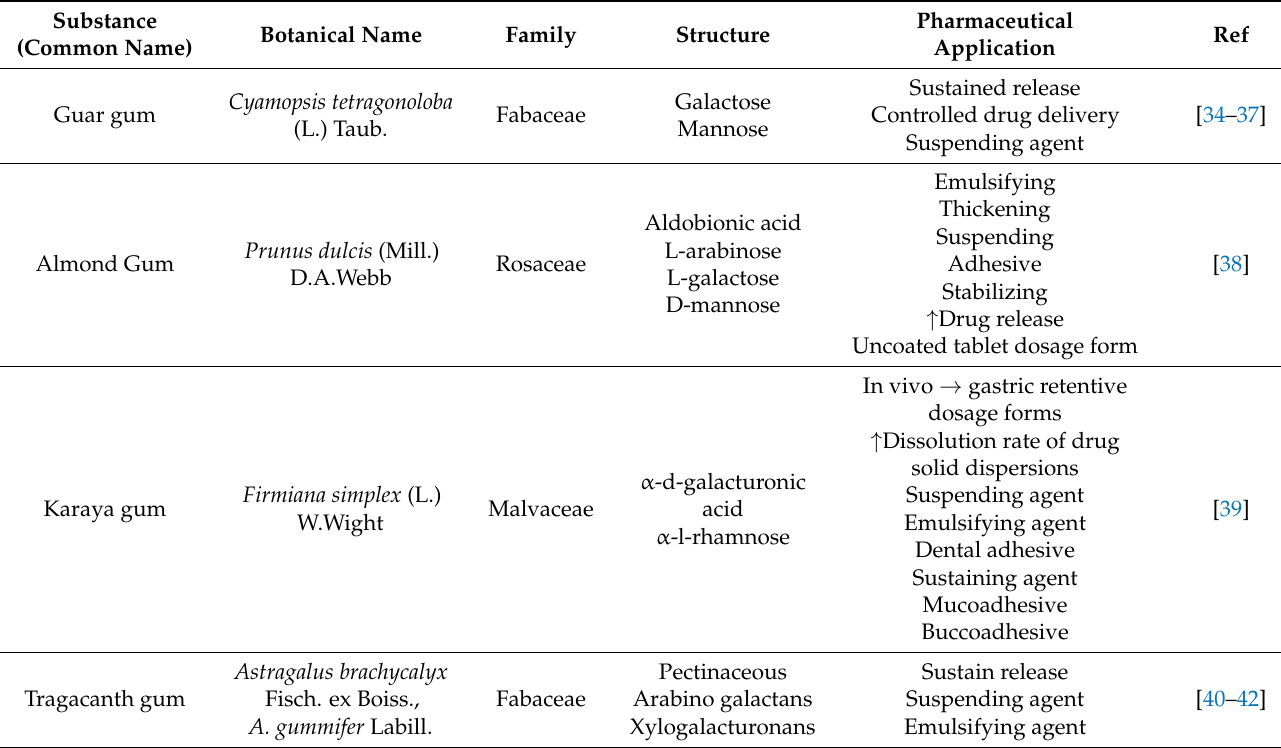
Table 1. Some of the most important botanical sources of gums and their pharmaceutical applications.